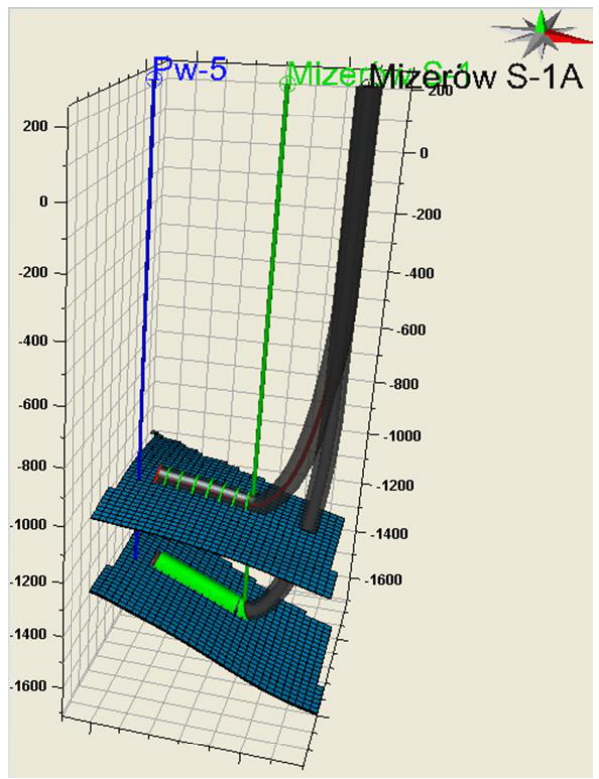
Figure 6. The layout of wells in the model of seams 405 and 510.